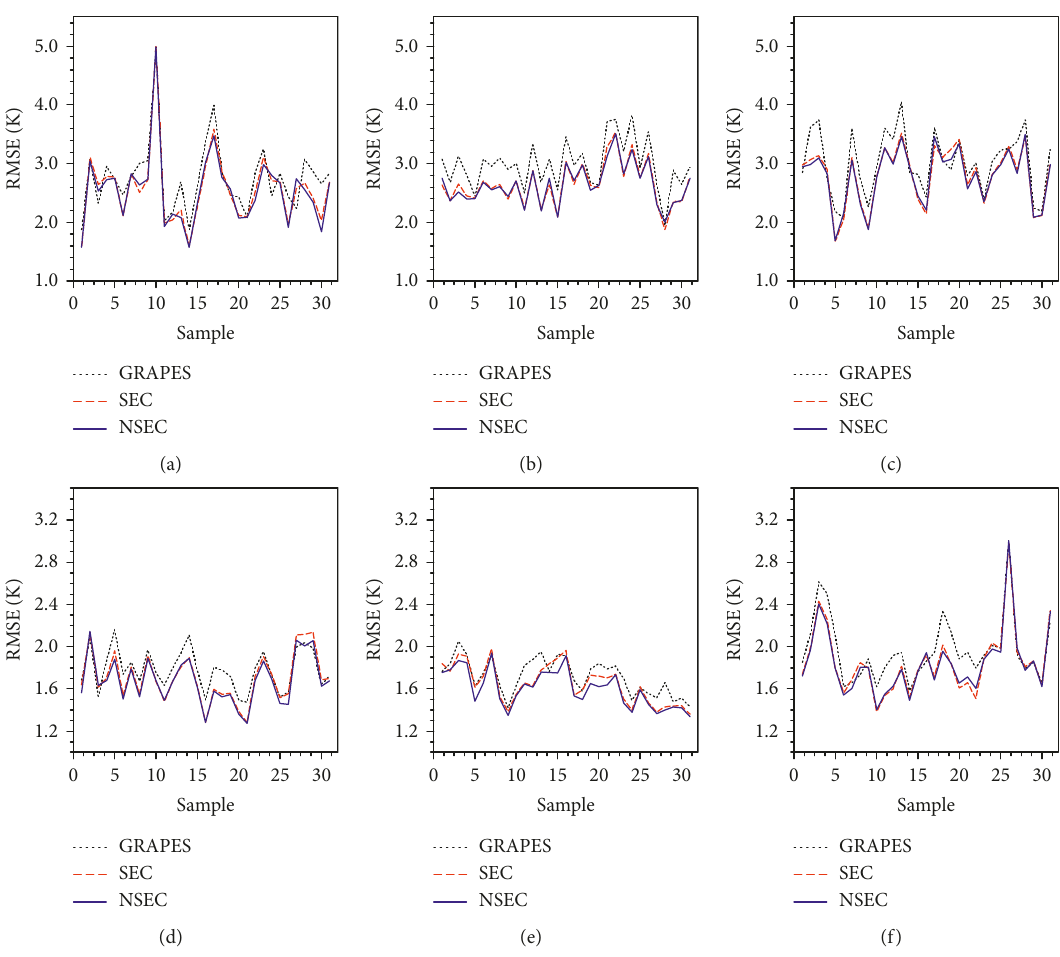
Figure 9: RMSE of 500hPa temperature of 24h forecast at January (a, b, and c) and July (d, e, and f) of 2008, 2009, and 2010, regarding the observational upper air temperature from MICAPS as the truth. The black lines (GRAPES) denote GRAPES model forecast, red lines (SEC) to the forecast after system correction, and blue lines (NSEC) to the forecast after correction of nonsystematic